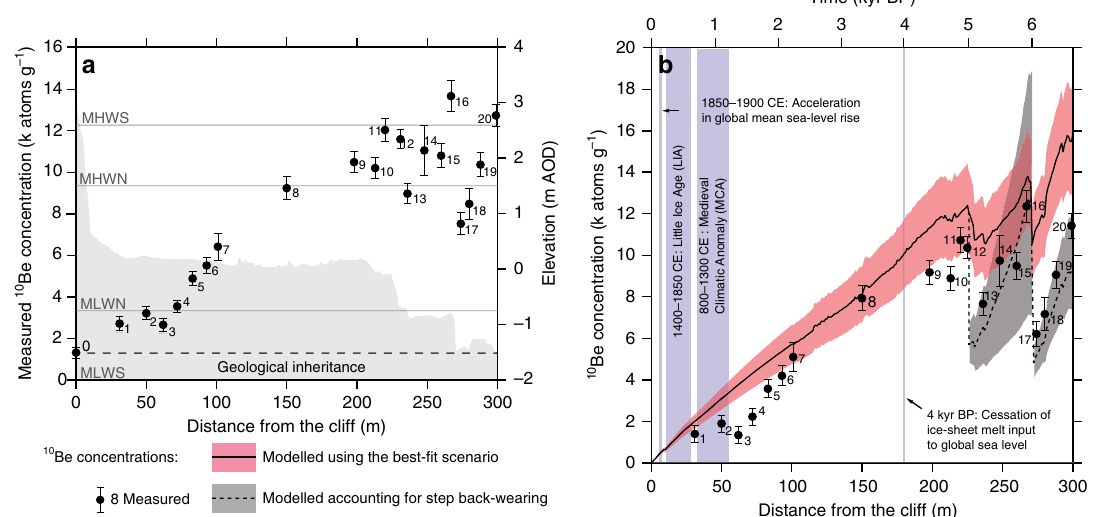
Fig. 2 Across-shore distribution of cosmogenic 10 Be concentrations. a Raw measured concentrations ± AMS measurement error and background uncertainty propagating in quadrature (Supplementary Note 1); dashed line delimits concentration due to deep muon production (geological inheritance); grey shadow (secondary axis) represents the elevation distribution across the pro fi le indicated in Fig. 1b; grey lines indicate tidal levels: MHWS = 2.59-m AOD: mean high water level of spring tides; MHWN = 1.50-m AOD: mean high water level of neap tides; MLWN = − 0.75-m AOD: mean low water level of neap tides; MLWS = − 2.01-m AOD: mean low water level of spring tides (https://www.ntslf.org/). b Measured concentrations corrected for geological inheritance (concentration at #0 subtracted from raw measurements) ± AMS measurement error and background- and inheritance uncertainties propagating in quadrature (Supplementary Note 1) and those modelled using the scenario of steady cliff retreat rate of 4.5 ± 0.63 cm yr − 1 and pro fi le- parallel coastal erosion (solid line and red error envelope). Dashed line and grey error envelope represent modelled concentrations, including the rate of step back-wearing (mean ± standard deviation). Vertical blue lines and boxes indicate major in fl uences on relative sea level at the study